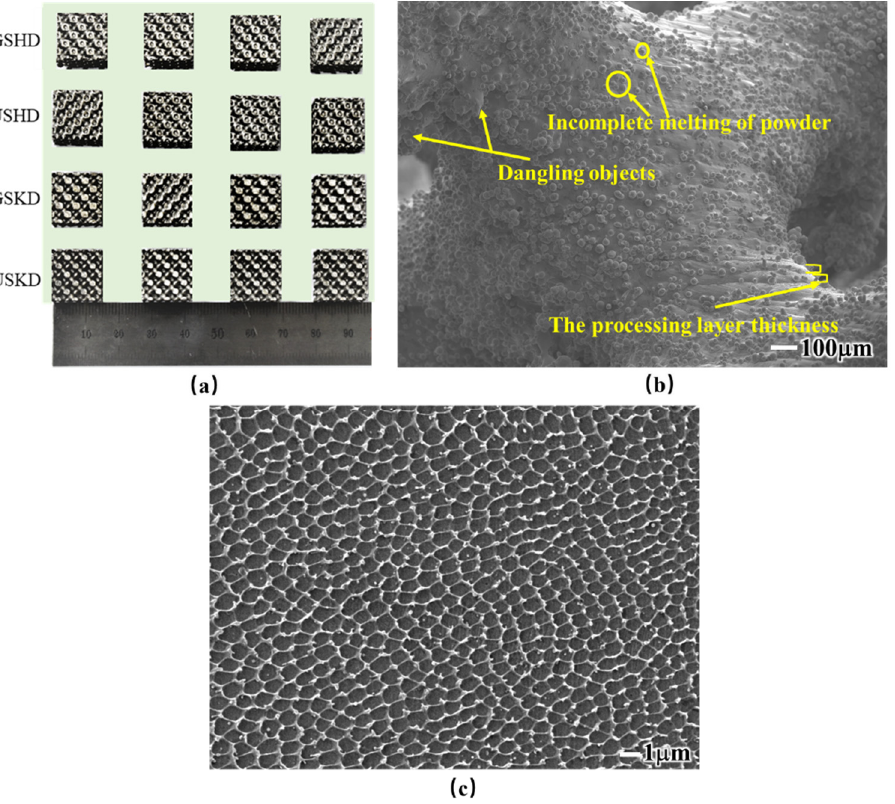
Figure 3. ( a ) Samples of Diamond lattice structures manufactured by SLM; SEM images of SLM- manufactured GSKD structure: ( b ) the microscopic structure of the upper surface; ( c ) the front view of a strut node.